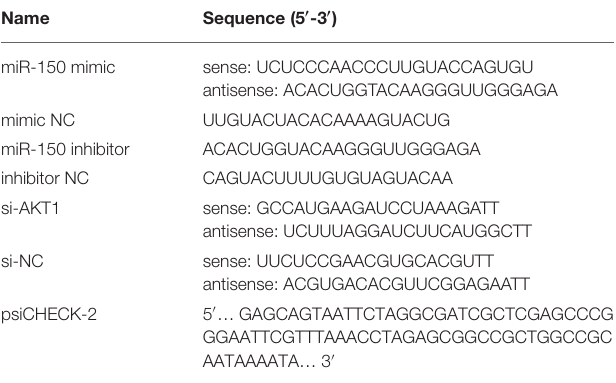
TABLE 1 | The sequence of RNA oligonucleotides and